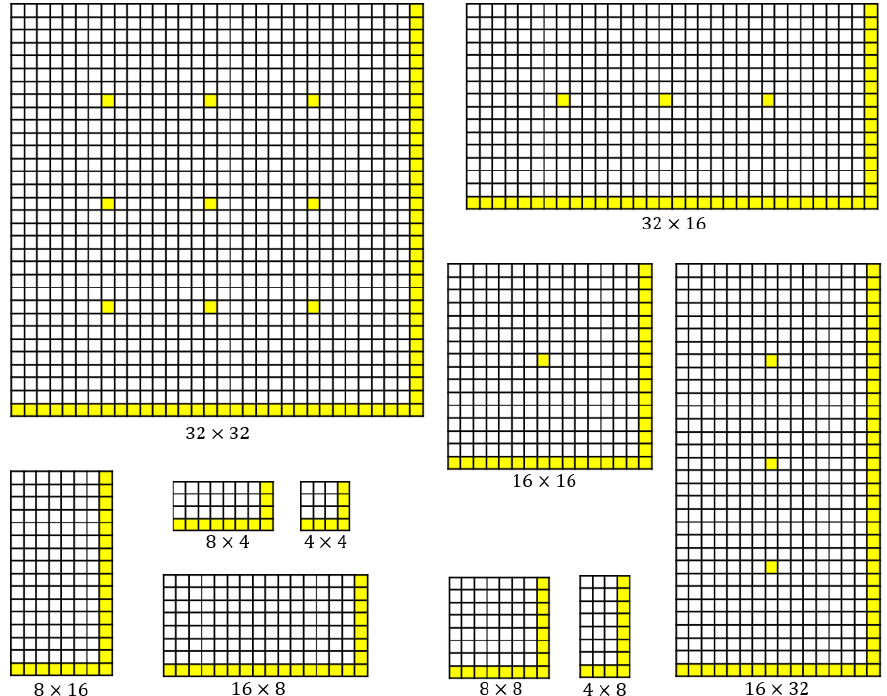
Figure 3. Pixels to be reconstructed for the proposed thumbnail extraction for various block shapes. Table 1. The number of pixels to be reconstructed for the block sizes.